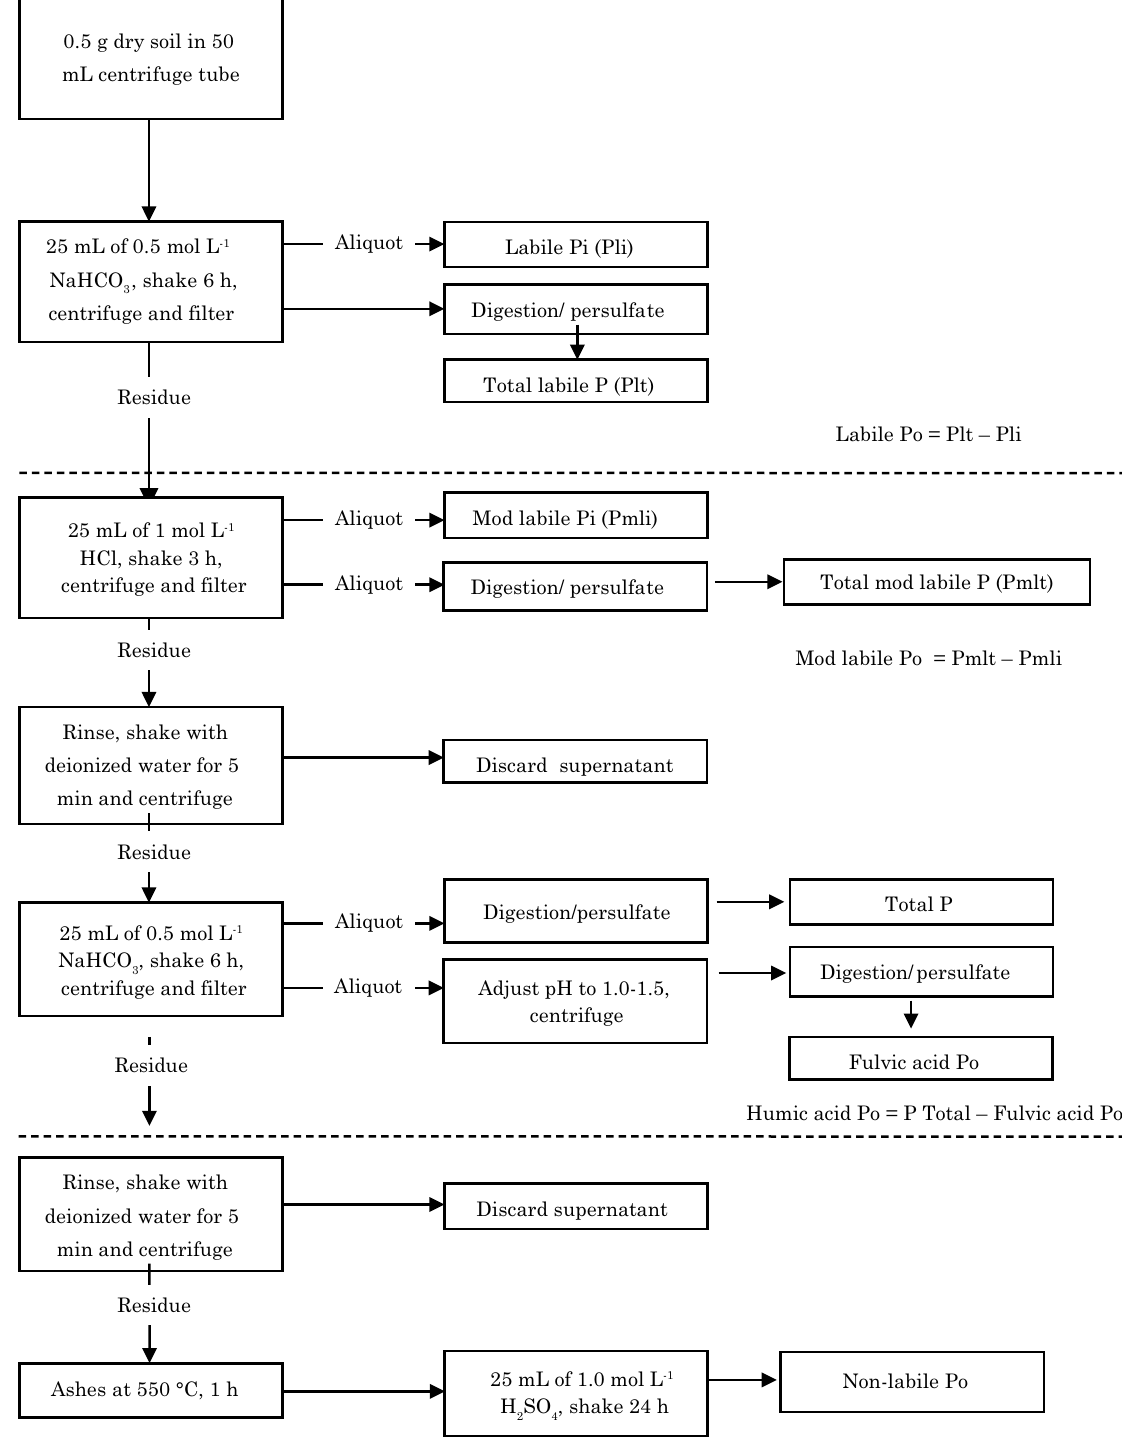
Figure 1. Organic P fractionation procedure, according to Kovar and Pierzynski (2009), with modifications of soil sample weight and reagent volumes, but unaltered